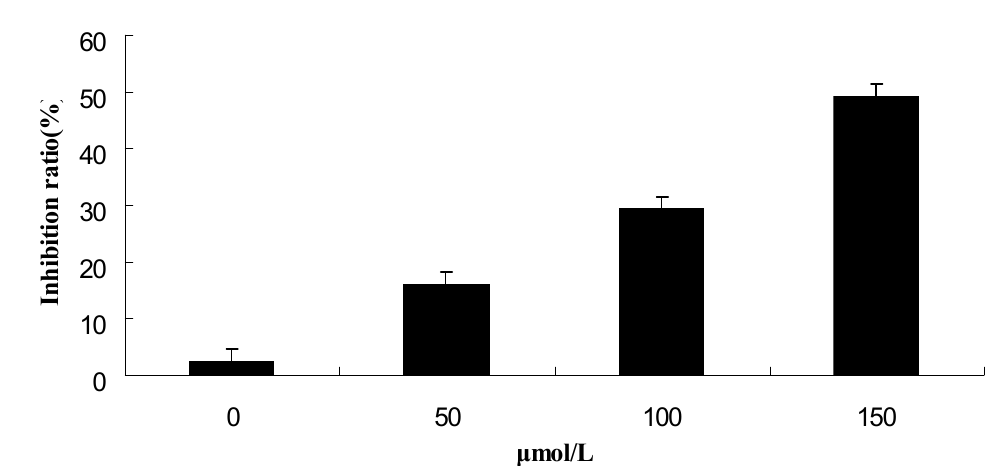
Figure 2. Results of the MTT assay.